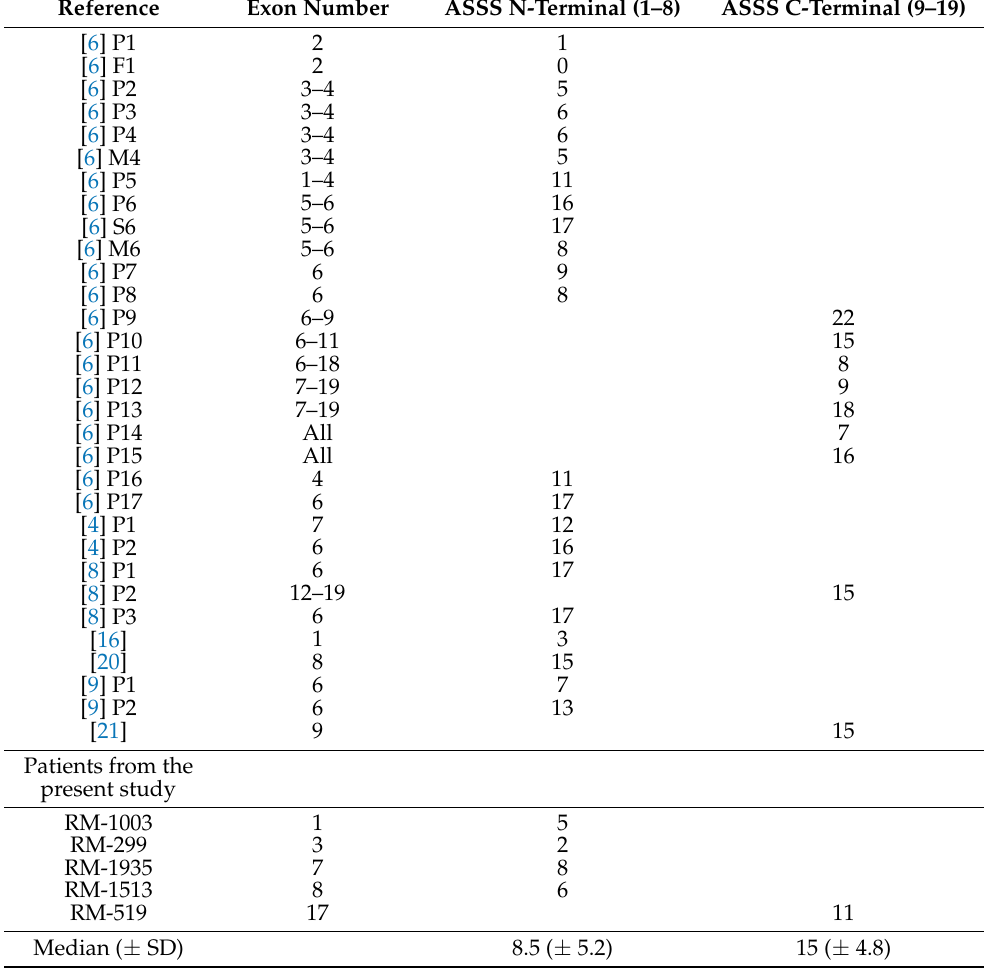
Table 2. ASSS Scores from AUTS2 Syndrome Patients from the Literature and our Cohort Sorted by the Location of the Variant on the N-terminal and C-terminal ends of the